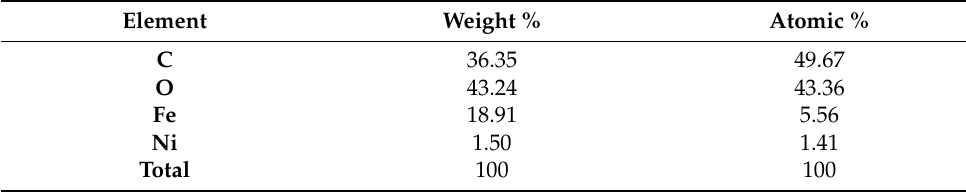
Figure 4. ( a ) SEM image of nickel magnetite and ( b ) CS-NM biocomposite.